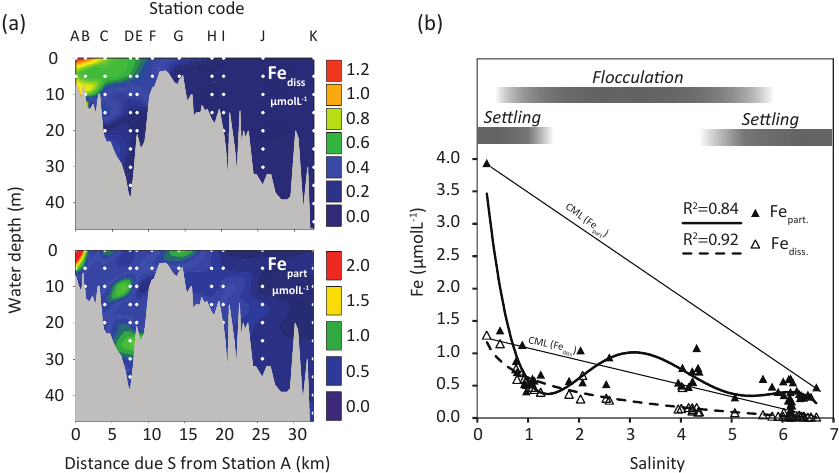
Figure 2. (a) 2-D contour plots of dissolved (top) and particulate (bottom) Fe in the water column along the Mustionjoki transect (Stations A– K), operationally defined by filtration at 0.45µm, June 2015. White circles represent sampling positions (vertical depth resolution = 5m). (b) Data from “a” plotted against salinity, including trend lines for Fe part (polynomial) and Fe diss (logarithmic). Linear conservative mixing lines (CMLs) are drawn between the high- and low-salinity end-member samples for Fe part and Fe diss . The inferred dominant processes controlling Fe part along the salinity transect are indicated by the grey